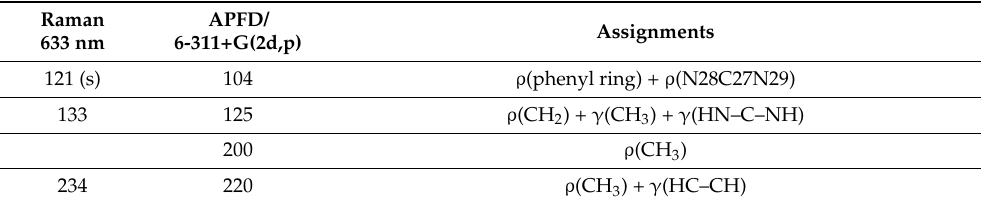
Table 1. Assignments of NOD from DFT-calculated Raman spectrum in gas phase, at APFD/6- 311+G(2d,p) level of